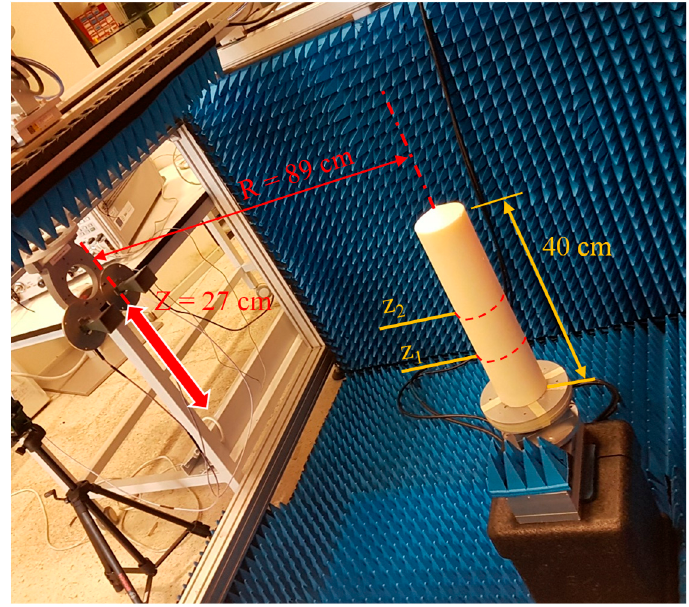
Figure 5. Picture of the wax candle placed on the rotary platform.